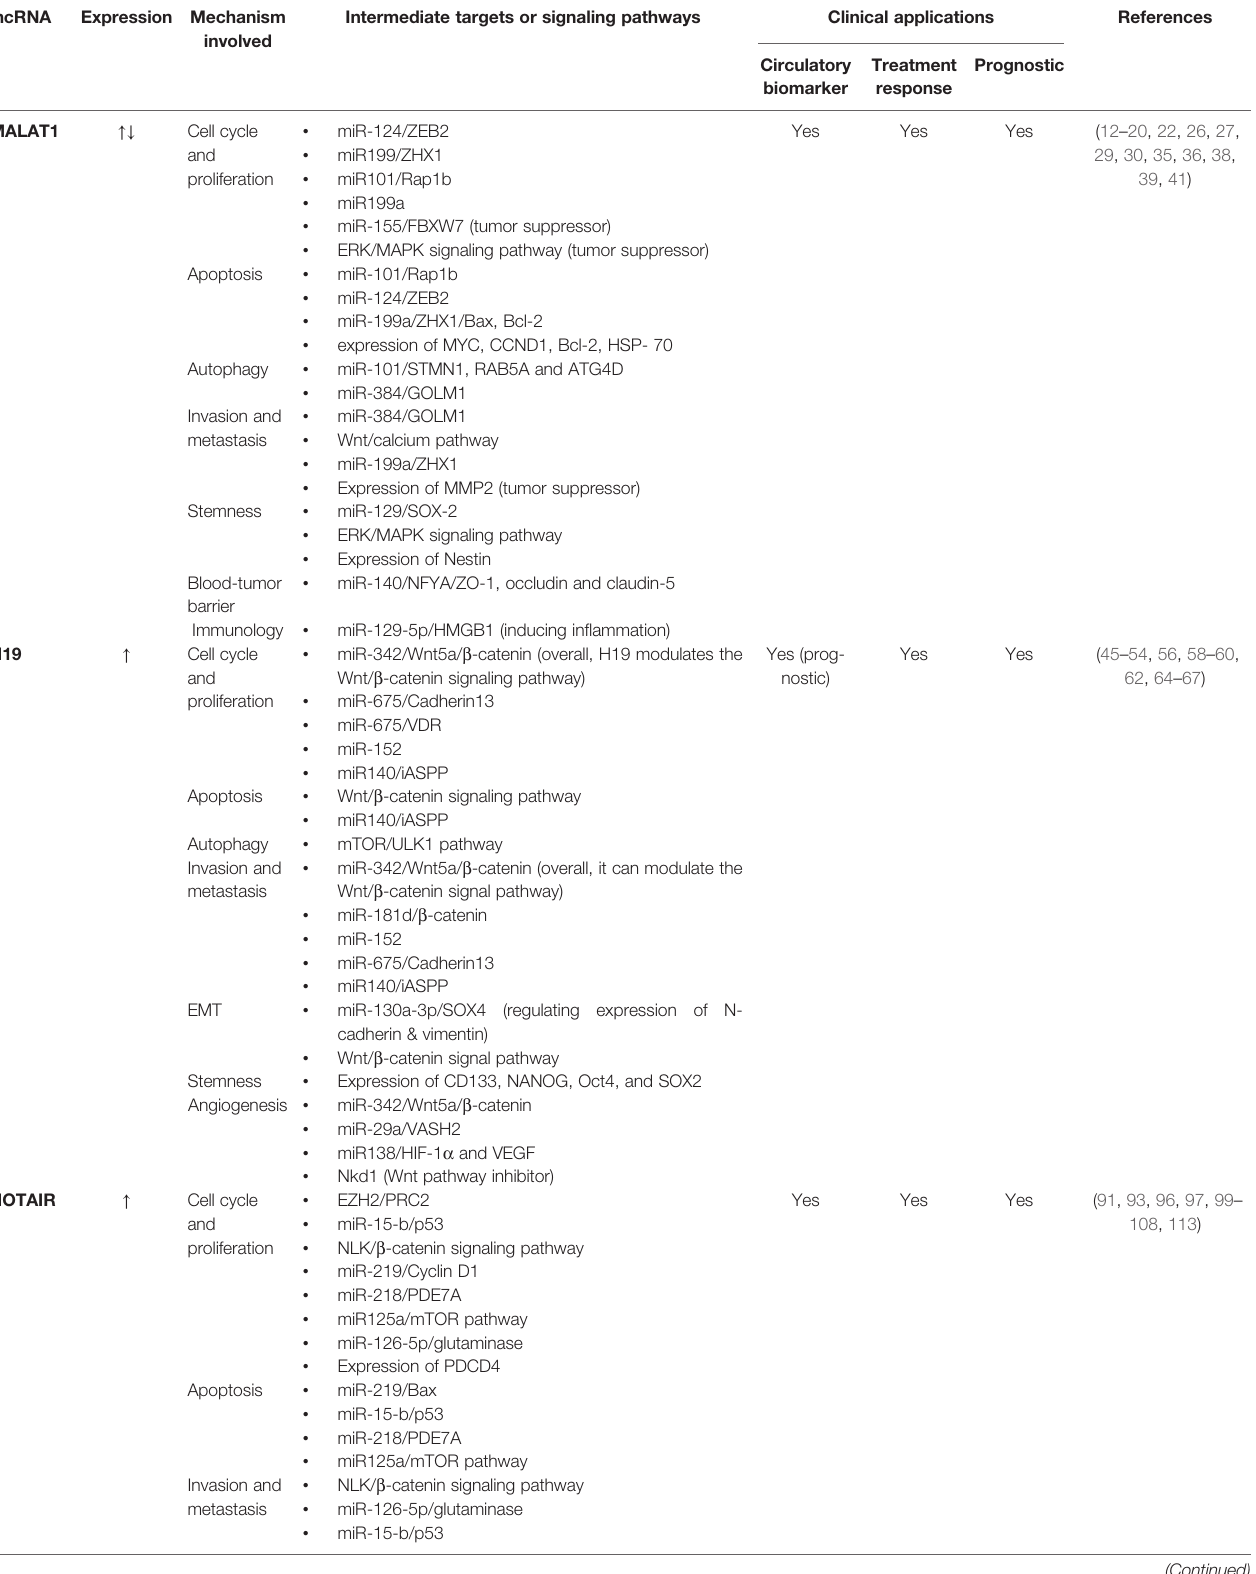
TABLE 1 | The most investigated oncogene lncRNAs and the so far discovered intermediate molecular pathways, in addition to their clinical applications. lncRNA Expression Mechanism